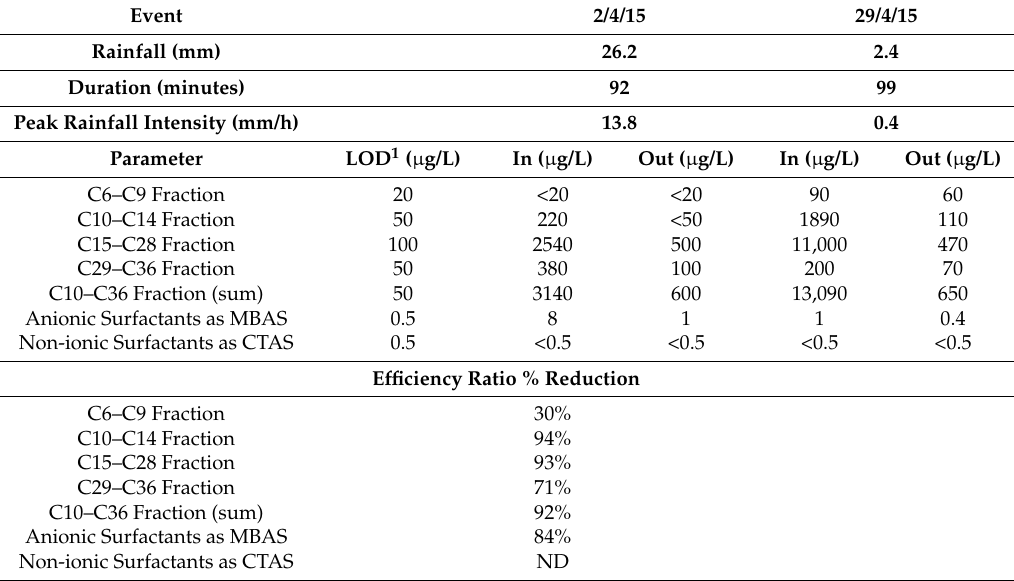
Table 5. Southport Water Quality